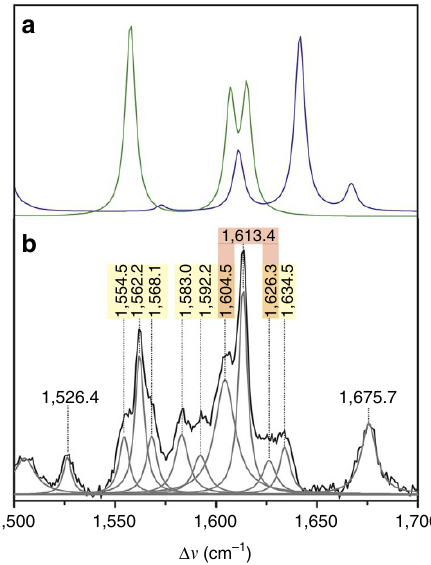
Figure 4 | Raman spectra of XenA. ( a ) Calculated spectra of reduced flavin (blue trace) and coumarin (green trace); ( b ), experimental RR spectrum of the reduced complex of Y183F-XenA and coumarin measured with 514-nm excitation. Yellow- and red-shaded peak labels indicate conjugate bands (triplets,